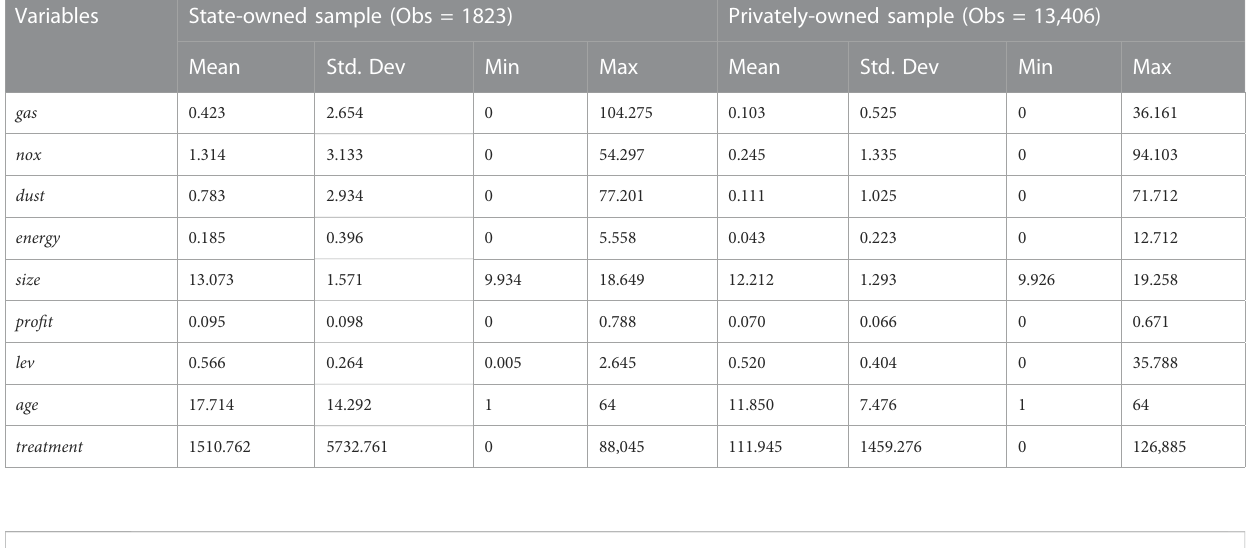
TABLE 1 Summary statistics of the key variables. Variables